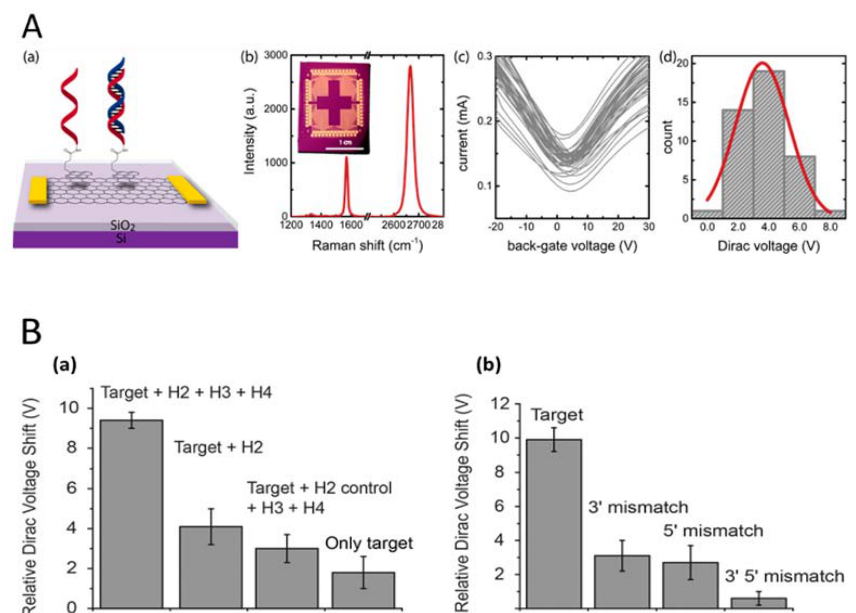
Figure 2. ( A ) ( a ) Schematic of DNA biosensor based upon a graphene field-effect transistor funct-ionalized with comple- mentary probe DNA. ( b ) Raman spectrum of the channel region of a graphene field-effect transistor (GFET) after processing. Inset: Optical micrograph of an array of 52 GFETs. ( c ) I-Vg characteristics for an array of 52 GFET devices showing excellent reproducibility. ( d ) Histogram of the Dirac voltage extracted from the I-Vg characteristics of the panel ( b ) along with a Gaussian fit to the data (red curve) [70]. Reprinted with permission from ref. [67]. 2016 American Chemistry Society. ( B ) Biosensor response to positive and negative controls. ( a ) Relative Dirac voltage shifts for various positive control experiments based upon concentrations of 1 µ m for the target DNA and the specified helper DNAs. ( b ) Relative Dirac voltage shifts for 10 nm target DNA and negative controls with base mismatches at the ends; detailed DNA sequences are listed in Table S1. Error bars are the standard deviation of the mean. Helper DNAs were 1 µ m. Reprinted with permission from ref. [65]. 2018 American Chemistry